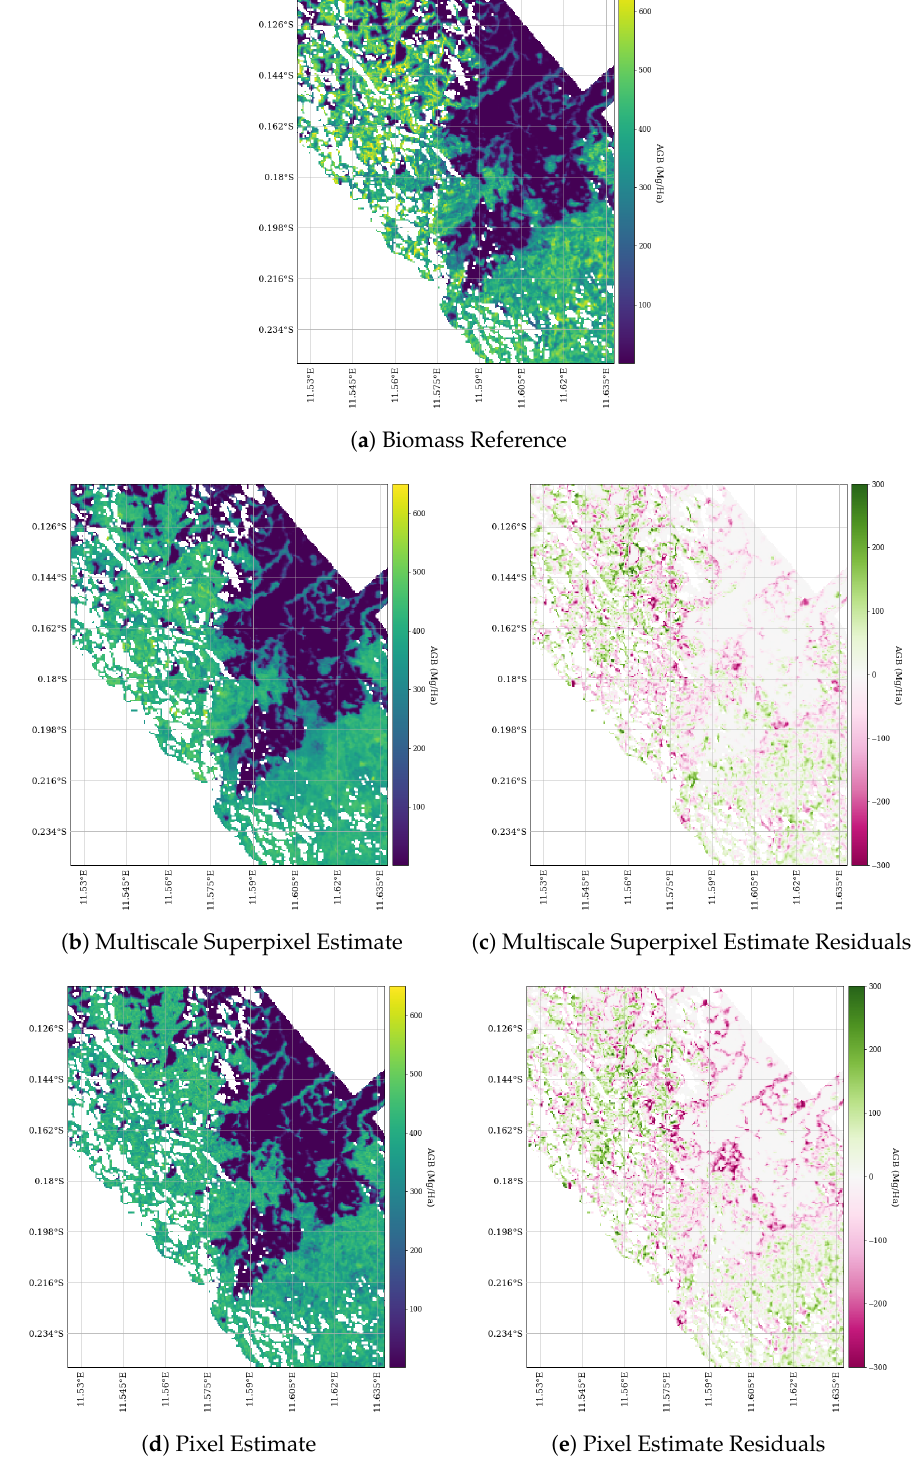
Figure 11. Comparison of the AGB reference map (top row) with those derived from multiscale superpixels (second row) and with those derived from pixels (bottom row) on a subset of Lope. Model is trained on and applied to full AGB